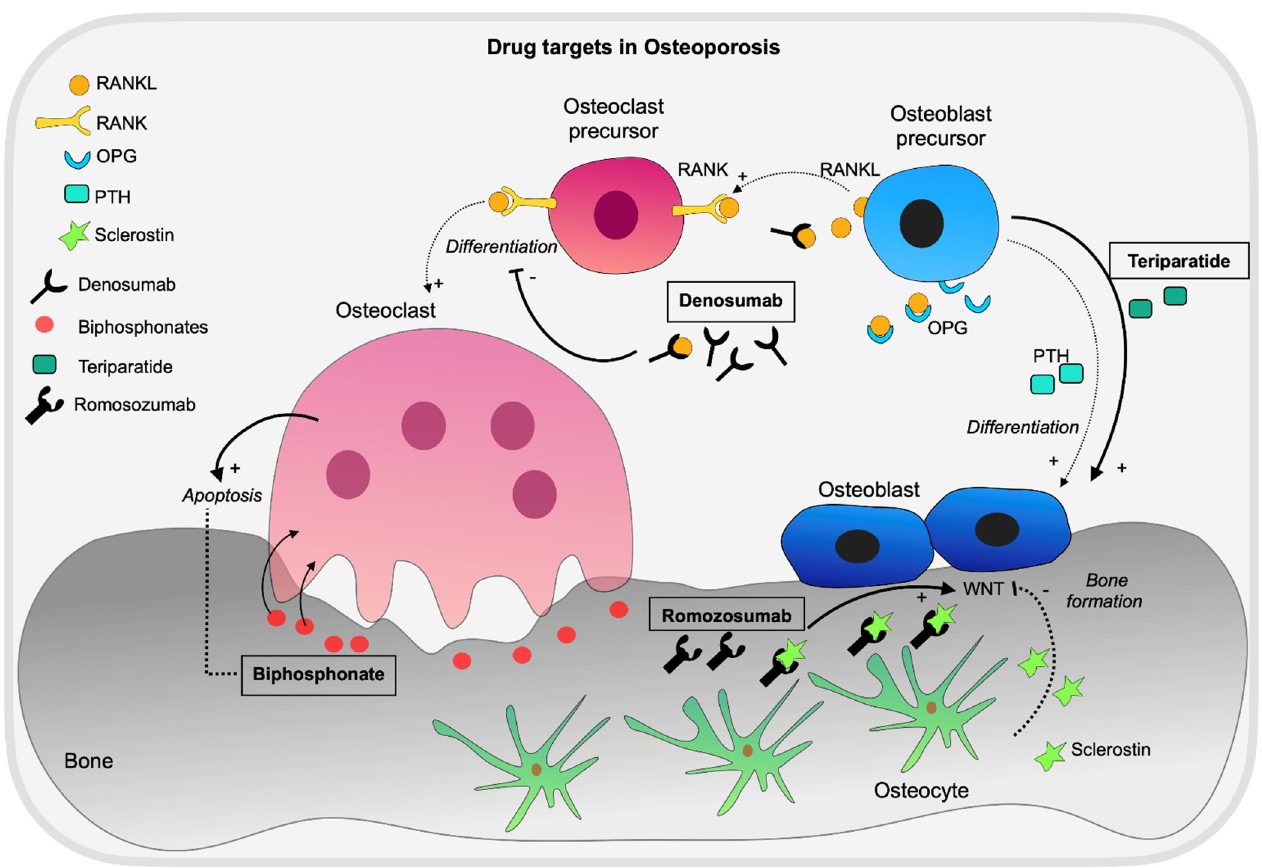
Figure 1. Timeline highlighting important milestones of GWAS for BMD. GWS (Genome-wide sig- nificant).